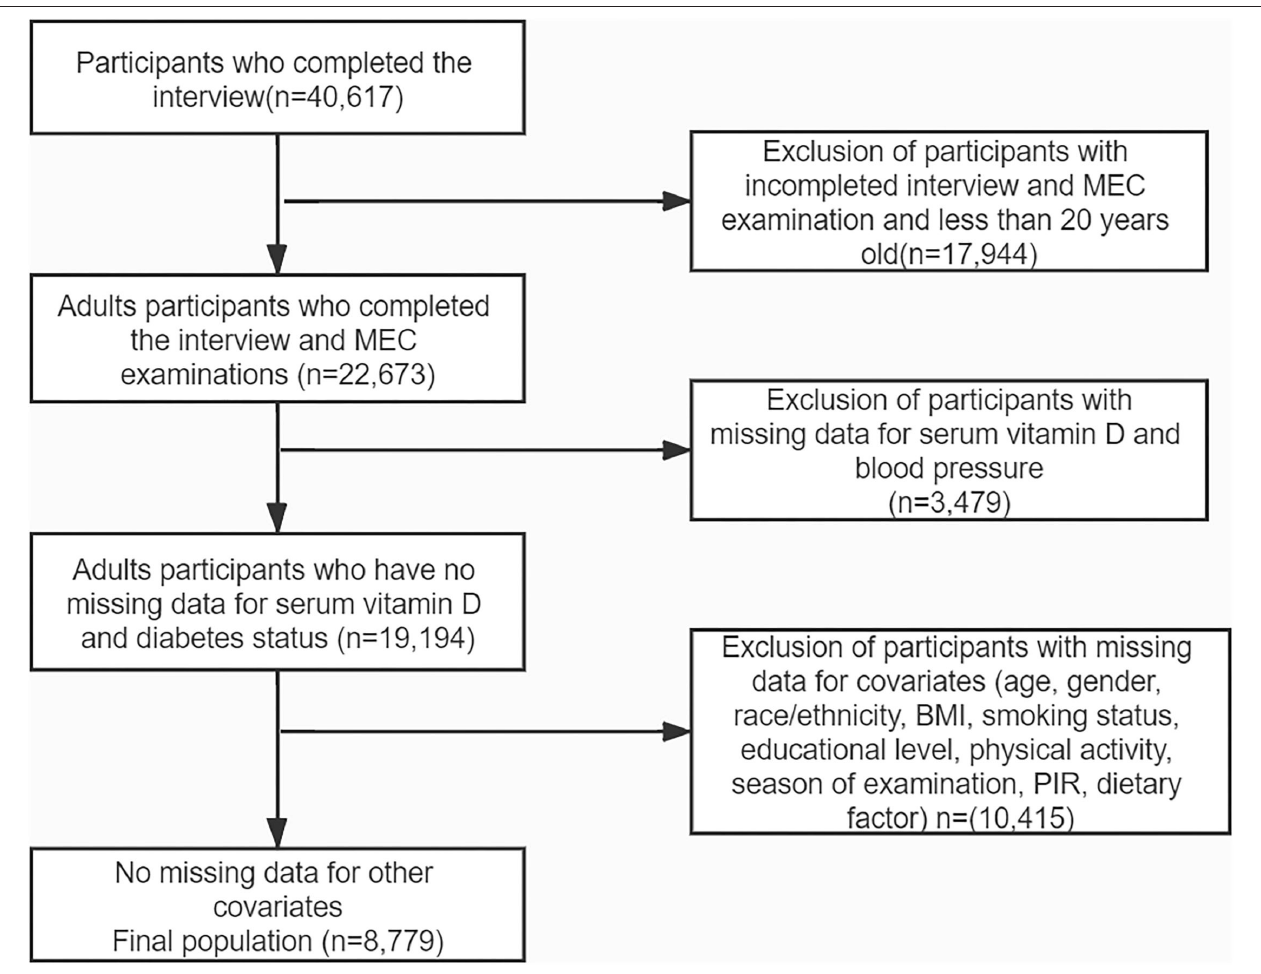
FIGURE 1 | Flowchart of participants